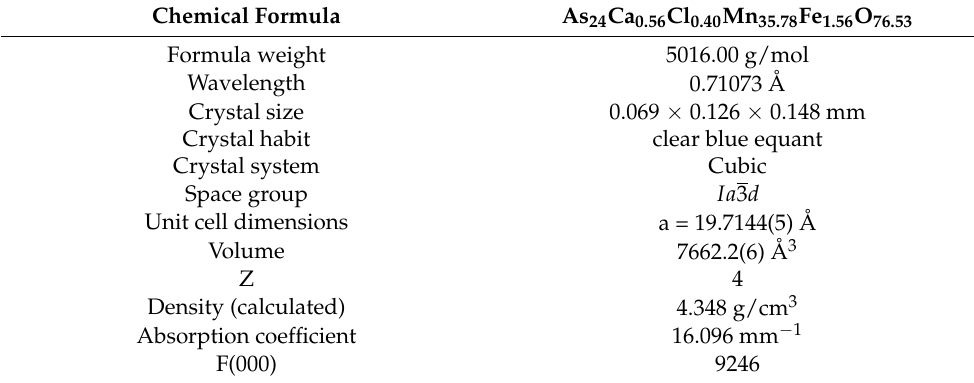
Table 2. Sample and crystal data for